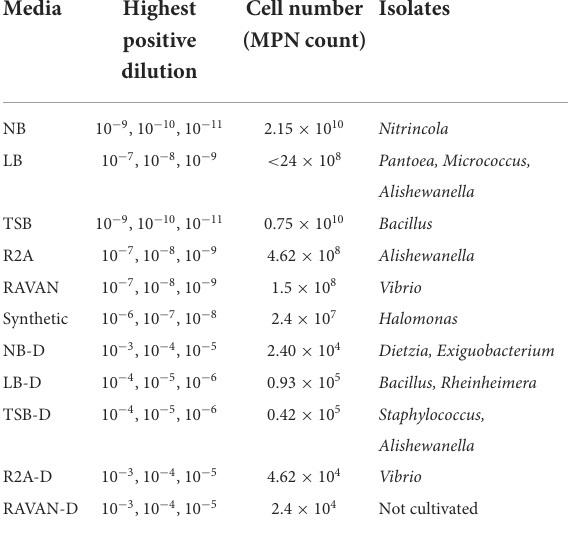
TABLE 1 Comparative study of bacterial load in oligotrophic and nutrient-rich mediums detected by MPN method and list of representative taxa cultivated from highest positive